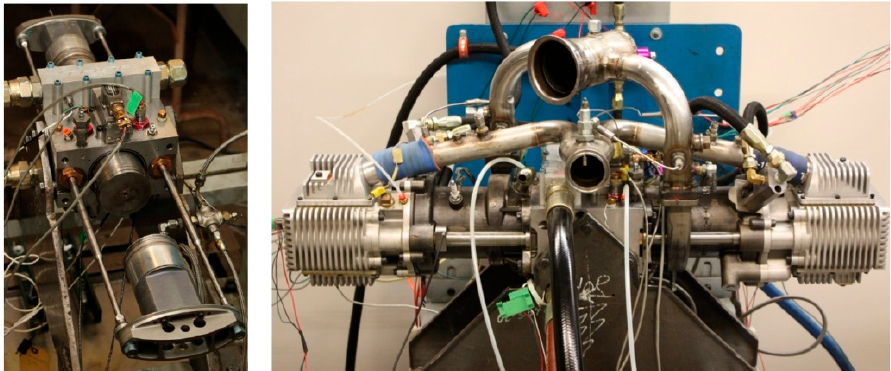
Figure 14. Demonstration of the HFPE principle of University of Minnesota [32].